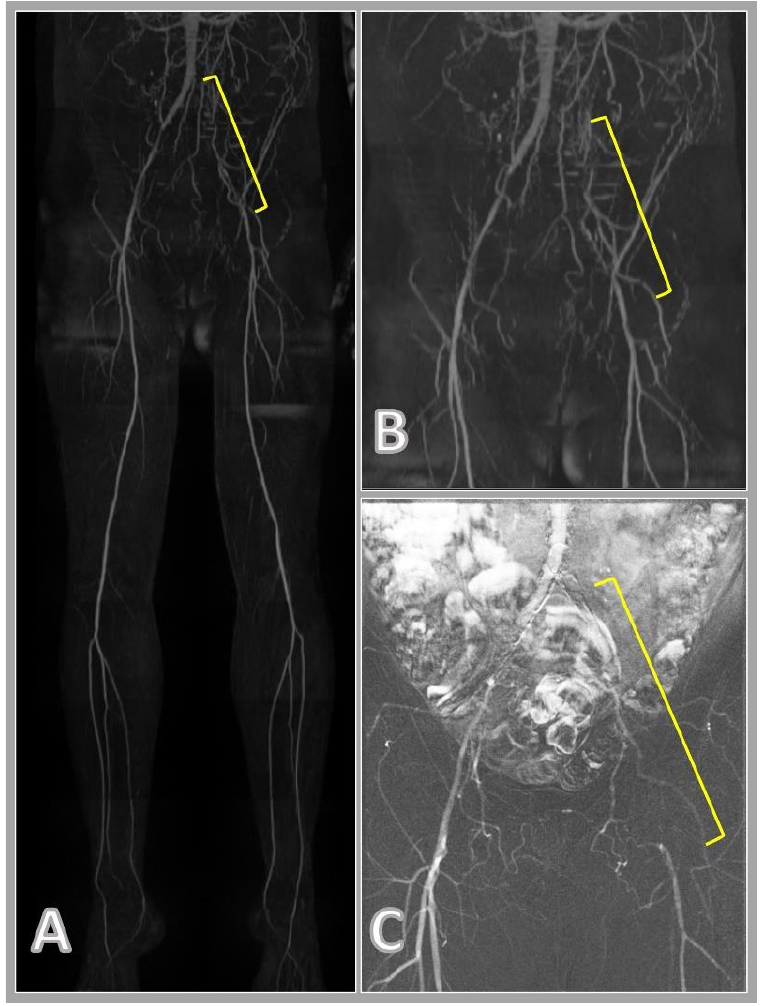
Figure 1. Comparison of quiescent-interval single-shot magnetic resonance angiography (QISS MRA ( A , B ); and carbon-dioxide digital subtraction angiography (CO2 DSA, ( C )) images. QISS MRA images clearly show the occlusion of the left common and external iliac artery and the resulting collateralization (yellow bracket). Assessment of this region with CO2 DSA is severely compromised by bowel movements.